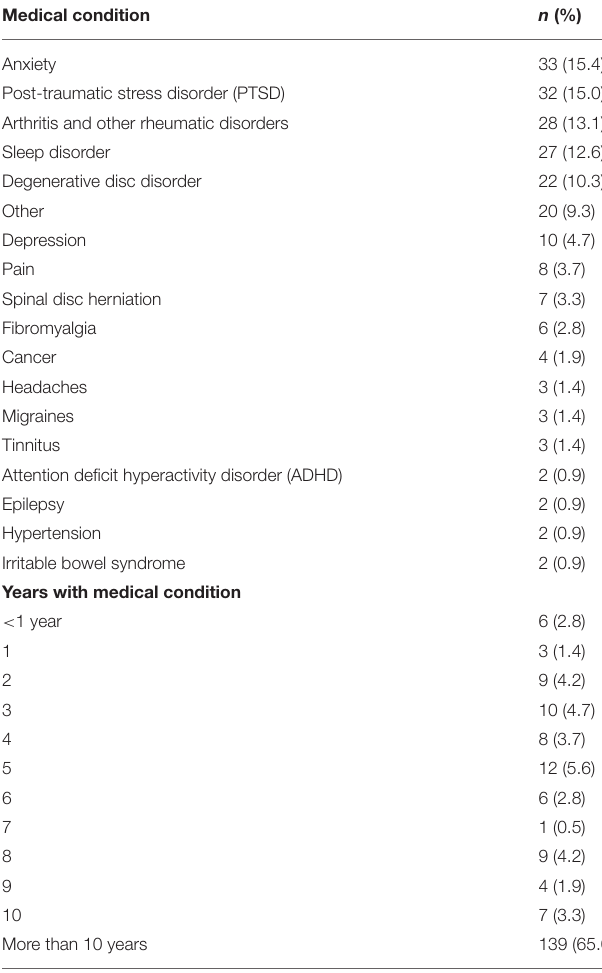
cannabis product (if any) had been the most helpful. Thirty- two percent of patients selected high CBD products and